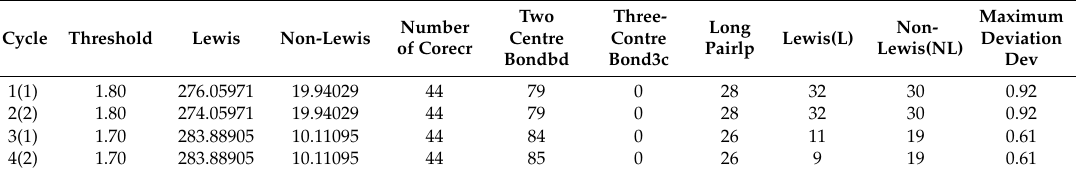
Figure 10. The molecular structure and energy corresponding with ( a ) CQD with 9 rings (CAM-B3LYP), ( b ) CQD with 10 rings (CAM-B3LYP), ( c ) CQD with 10 rings (B3LYP), ( d ) CQD with 12 rings (CAM-B3LYP). Table 5. Natural bond orbital of CQD with 10 rings using CAM-B3LYP